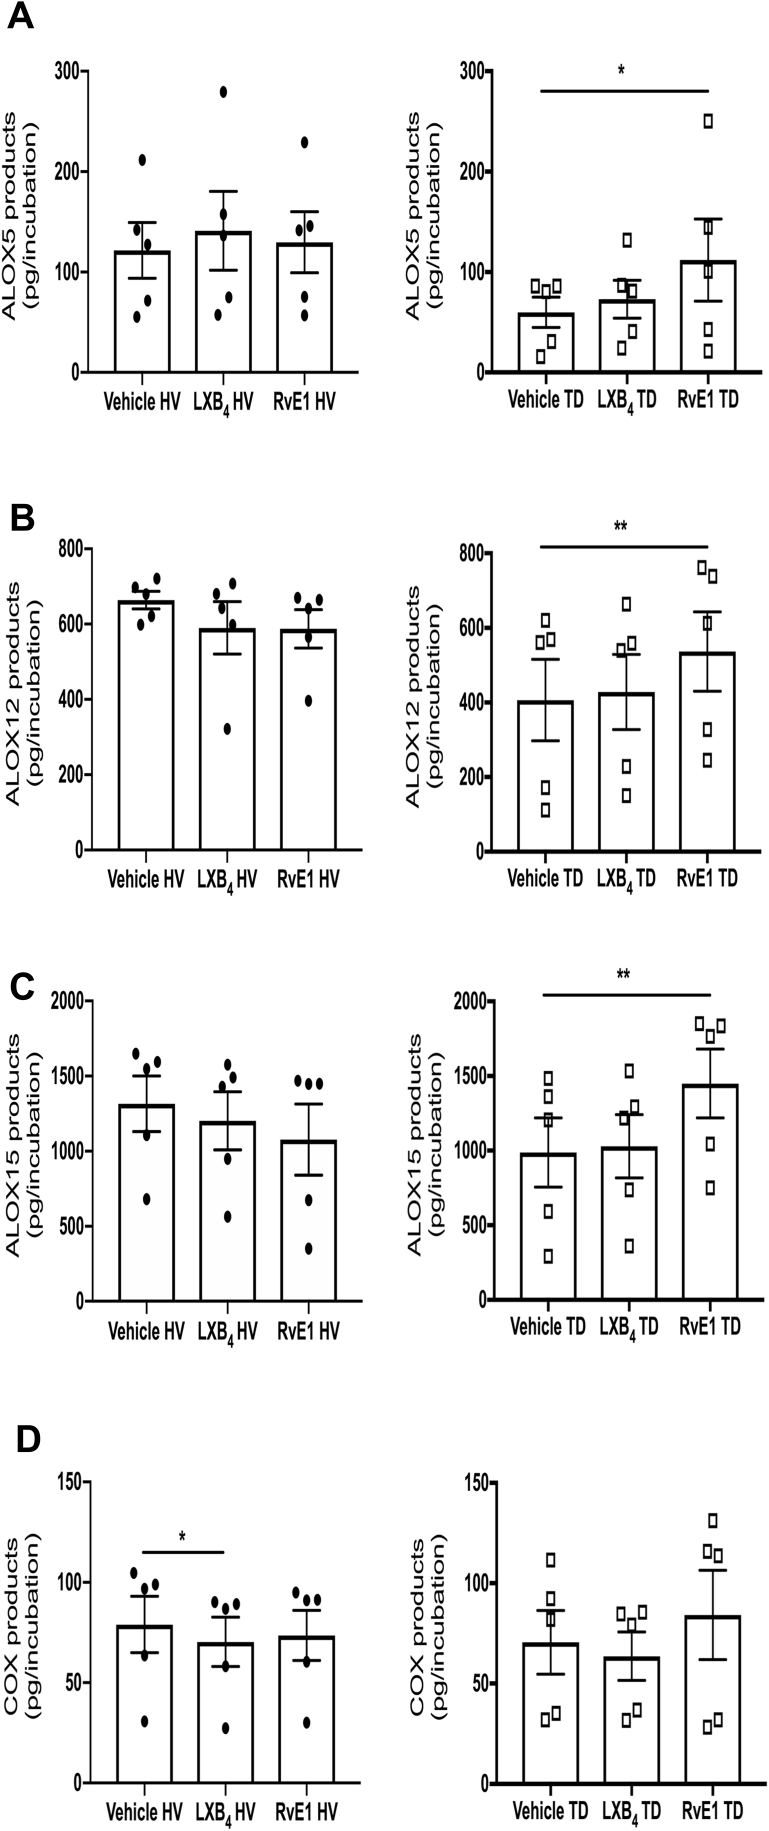
Differential regulation of specialized proresolving mediator (SPM) biosynthetic enzyme activity by resolvin E1 (RvE1) and lipoxin B4 (LXB4) in patient-derived and healthy (H) volunteer tendon stromal cells. Tendon stromal cells were derived from the H group (n = 5 donors) and patients with shoulder tendon tears or the diseased (D) group (n = 5 donors). Cells were incubated with 10 nmol/L RvE1, 10 nmol/L LXB4, or vehicle for 24 hours at 37°C then with 10 ng mL−1 of IL-1β for 24 hours. Monohydroxy fatty acids–produced SPM biosynthetic enzymes were identified and quantified using liquid chromatography with tandem mass spectrometry–based lipid mediator profiling. Cumulative concentrations of the 5-lipoxygenase (ALOX5) products 7-hydroxydocosahexaenoic acid, 7-hydroxydocosapentaenoic acid, 5-hydroxyeicosapentaenoic acid, and 5-hydroxyeicosatetraenoic acid (A); the 12-lipoxygenase (ALOX12) products 14-hydroxydocosahexaenoic acid, 14-hydroxydocosapentaenoic acid, 12-hydroxyeicosapentaenoic acid, and 12-hydroxyeicosatetraenoic acid (B); the 15-lipoxygenase (ALOX15) products 17-hydroxydocosahexaenoic acid, 17-hydroxydocosapentaenoic acid, 15-hydroxyeicosapentaenoic acid, and 15-hydroxyeicosatetraenoic acid (C); and cyclooxygenase (COX) products 17-hydroxydocosahexaenoic acid and 17-hydroxydocosapentaenoic acid (D). Data are expressed as means ± SEM. *P < 0.05, **P < 0.01 versus respective vehicle control (Friedman's test followed by Dunn's post hoc test).